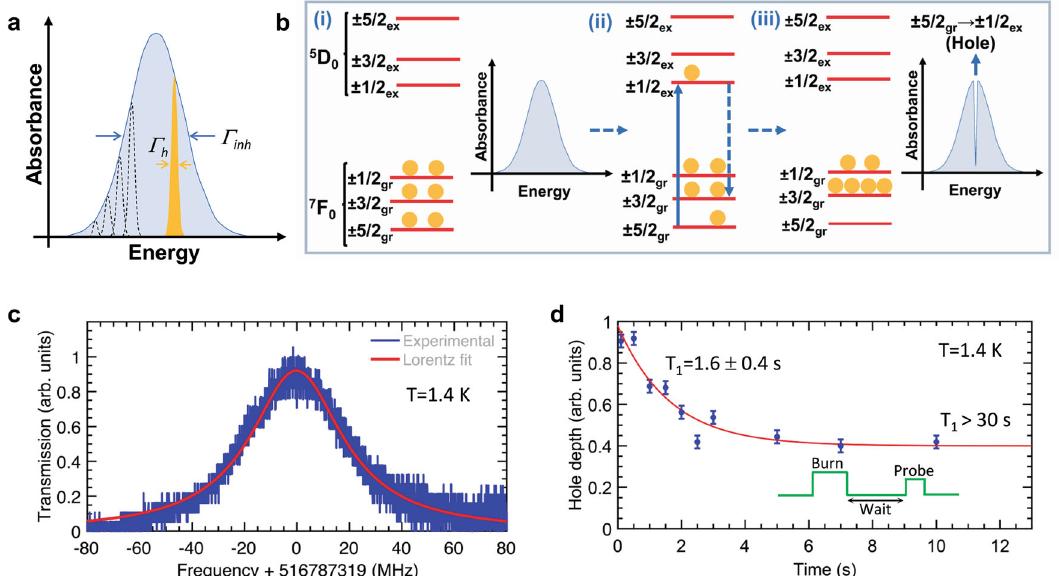
Fig. 3 Spectral hole burning (SHB) in the 5 D 0 → 7 F 0 transition of [Eu 2 ]. a An inhomogeneously ( Γ inh ) broadened line is composed of narrow homogeneously ( Γ h ) broadened lines. Selective optical excitation of one or several homogeneously broadened lines is used to burn spectral holes with implications for QIP applications. b Simpli fi ed mechanism of SHB. In the diagram, ±1/2 gr , ±3/2 gr , ±5/2 gr , and ±1/2 ex , ±3/2 ex , and ±5/2 ex correspond to nuclear spin levels associated with the ground 7 F 0 and excited 5 D 0 states, respectively. (i) A laser scan reveals an inhomogeneously broadened absorption spectrum, like the one shown in ( a ), due to the excitation of multiple ions ensembles with in fi nitesimally small energy difference. (ii) Selective and continuous laser pumping transfers the population from one of the ground-state spin levels to an excited-state spin level. This is illustrated for ions with the ±5/2 gr ( 7 F 0 ) to ±1/2 ex ( 5 D 0 ) transition resonant with the laser. (iii) Population relaxation from level ±1/2 ex to level ±3/2 gr , under the ambit of level ±3/2 gr having suf fi ciently longer lifetime than levels ±1/2 gr and ±5/2 gr , results in a decreased population in level ±5/2 gr . Since the spin level splittings are much lower than the optical inhomogeneous broadening, the laser will excite other ions along with transitions from the ±3/2 gr or ±1/2 gr levels, which will therefore be emptied. This fi nally results in a hole in the inhomogeneously broadened absorption spectrum. c Spectral hole burned in the 5 D 0 → 7 F 0 transition of [Eu 2 ]. A Lorentzian fi t reveals an FWHM of 43 ± 2 MHz, corresponding to Γ h = 22 ± 1 MHz. A T 2opt = ~14.5 ns is calculated using the relation Γ = (1/ π T h 2opt ). d The decay of the hole depth as a function of delay time before readout, showing the relaxation rate of the nuclear spin levels in the binuclear complex. a and b are partially reproduced with permission from ref. 23